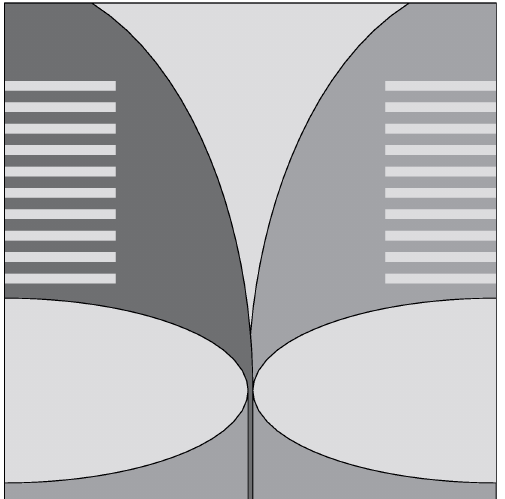
Figure 12. Schematic of the corrugated AVA design (redrawn from [64]). Dark gray top metal face, medium gray bottom metal face, and light gray dielectric